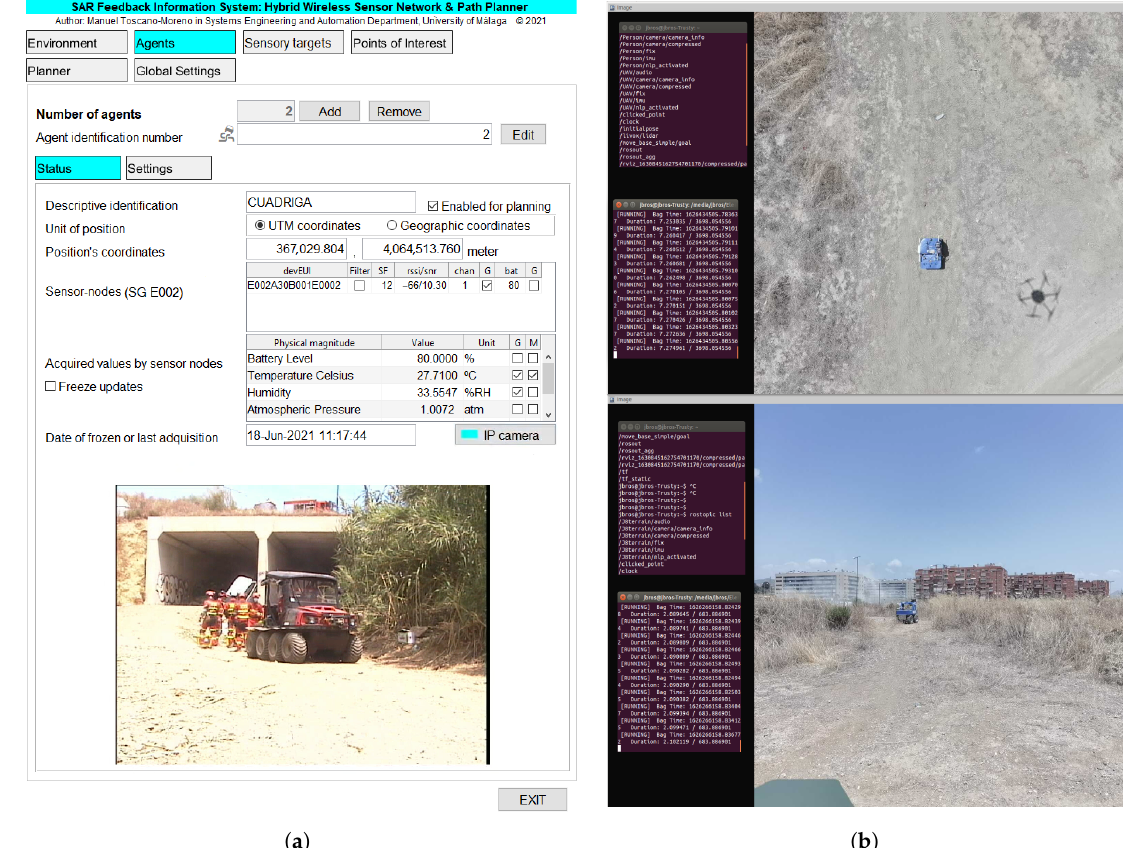
Figure 6. Examples of camera images visualization in FCC and BCC. ( a ) SAR-FIS: video supported by video web server from onboard IP camera on Cuadriga. ( b ) ROS-FIS: video from 5G smartphones on UAV and Rover J8 monitored in